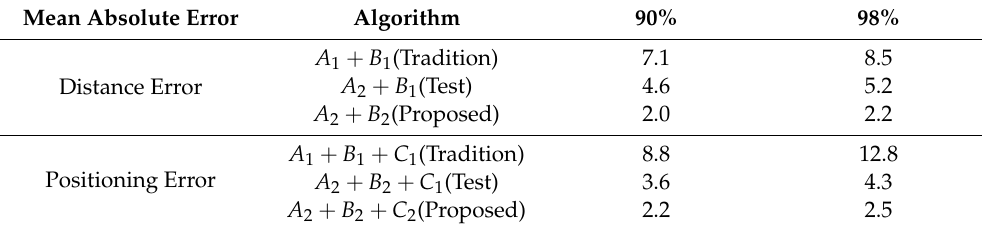
Table 5. Comparison of the precision of the mean absolute error